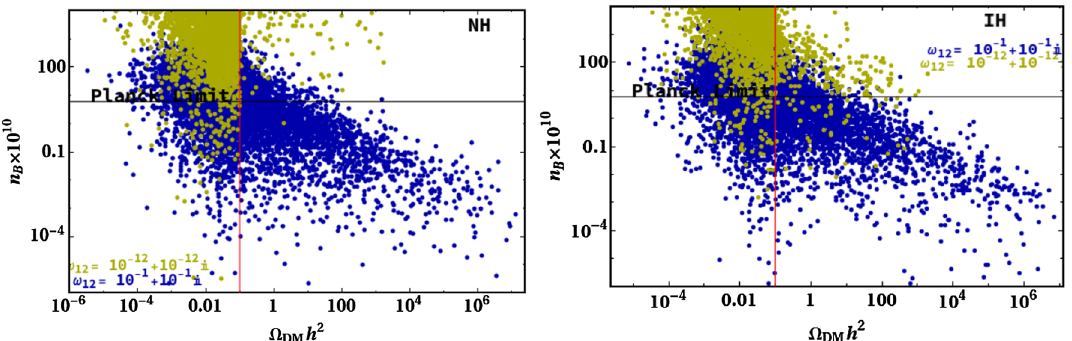
Fig. 4 Baryon asymmetry of the Universe as a function of relic abundance of the dark matter candidate ξ for NH/IH with the consideration of two different values of arbitrary angle ω 12 and benchmark values of ω 13 = 10 − 3 + 10 − 3 i and ω 23 = 10 − 2 + 10 − 2 i